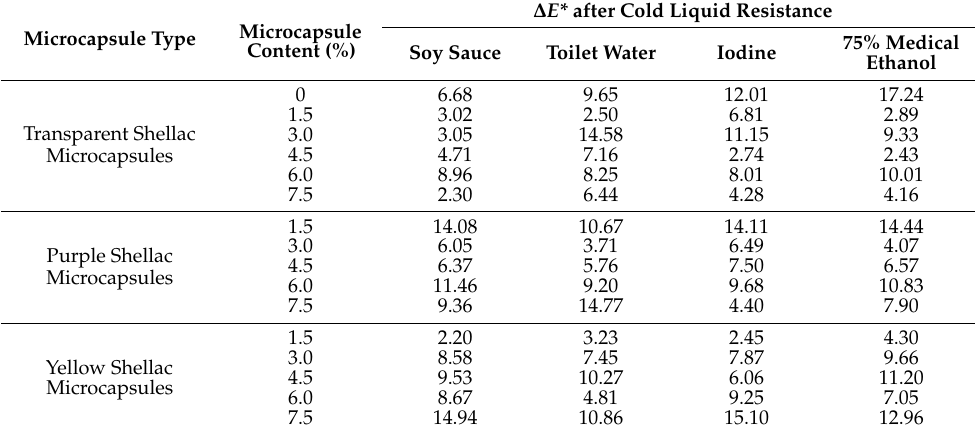
Table 9. The ∆ E* of coating on Beli wood with the content of different shellac microcapsules in the coating after the cold liquid resistance